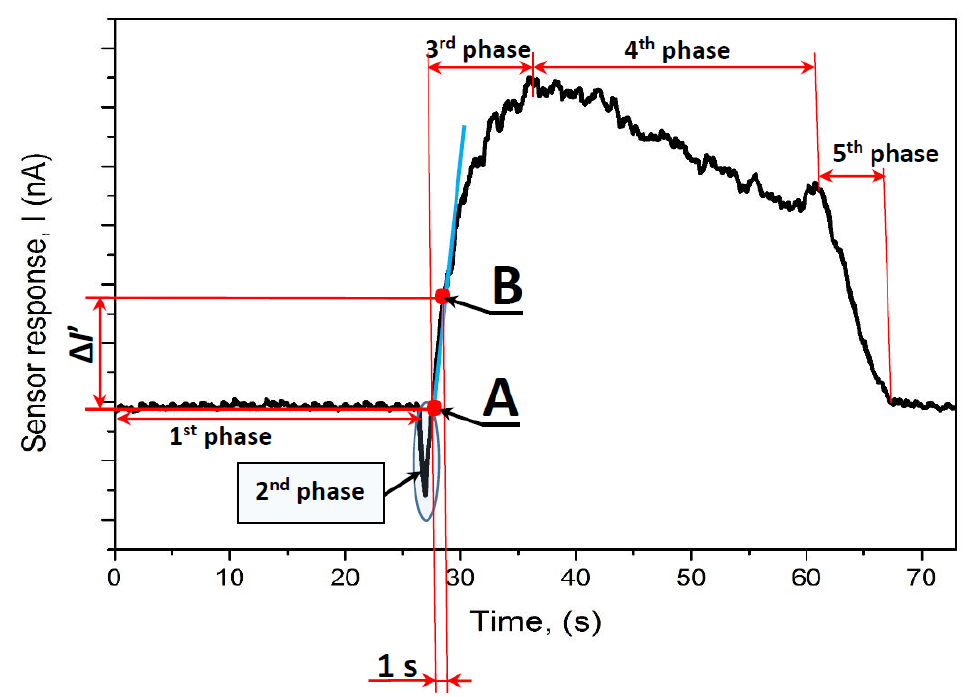
Figure 3. Assessment of kinetics-based analytical signal (Δ I’ ) from typical WO 3 /WO 3−x -based sensor response towards vapor of different VOCs (methanol, ethanol, isopropanol, acetone) and ammonia gas at temperatures between 60 and 270 °C along with a scheme of Δ I’ calculation, which indicates the increase of current during 1 s lasting period.